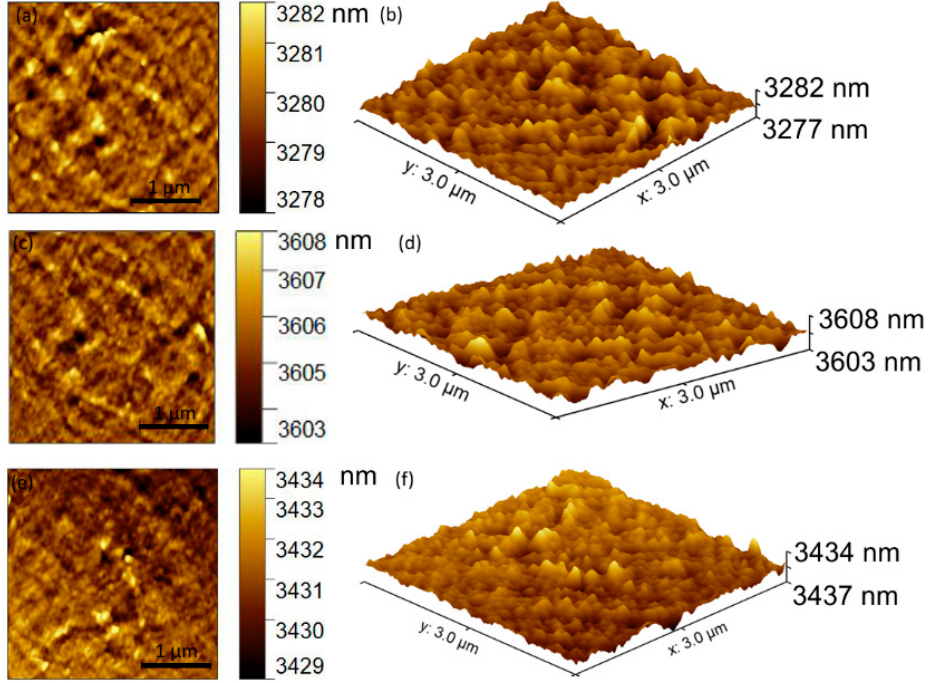
Figure 5. 2D AFM topography of HAp ( a ), 0.05 AgHAp ( c ), and 0.1 AgHAp ( e ) coatings and 3D representation of the 2D AFM topographies of HAp ( b ), 0.05 AgHAp ( d ), and 0.1 AgHAp ( f ) coatings. Table 2. Root mean square roughness (R RMS ) value for HAp, 0.05 AgHAp, and 0.1 AgHAp coat- ings.